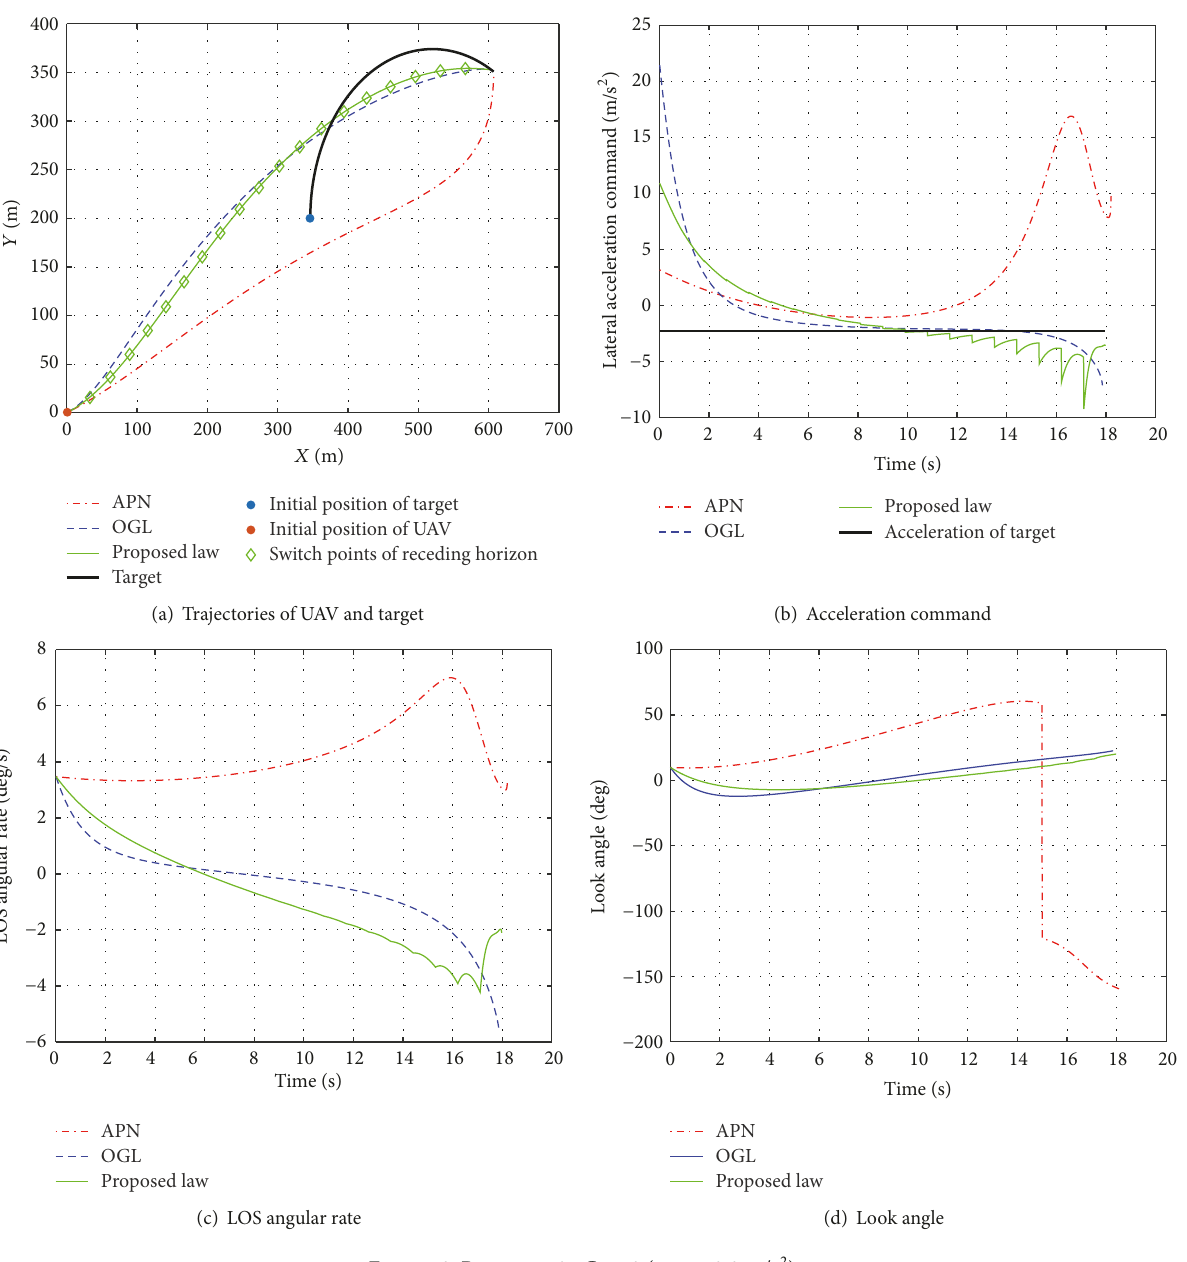
Figure 8: Responses in Case 2 (𝑎 𝑇 = −2.3 m / s 2 )